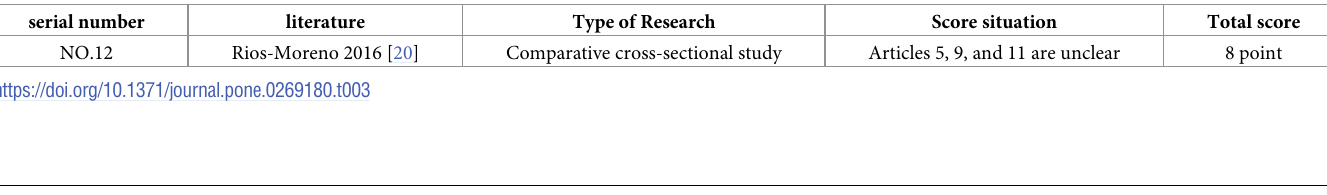
enteral feeding. The fortified formula has the right mineral ratio, balanced nutrients, and the